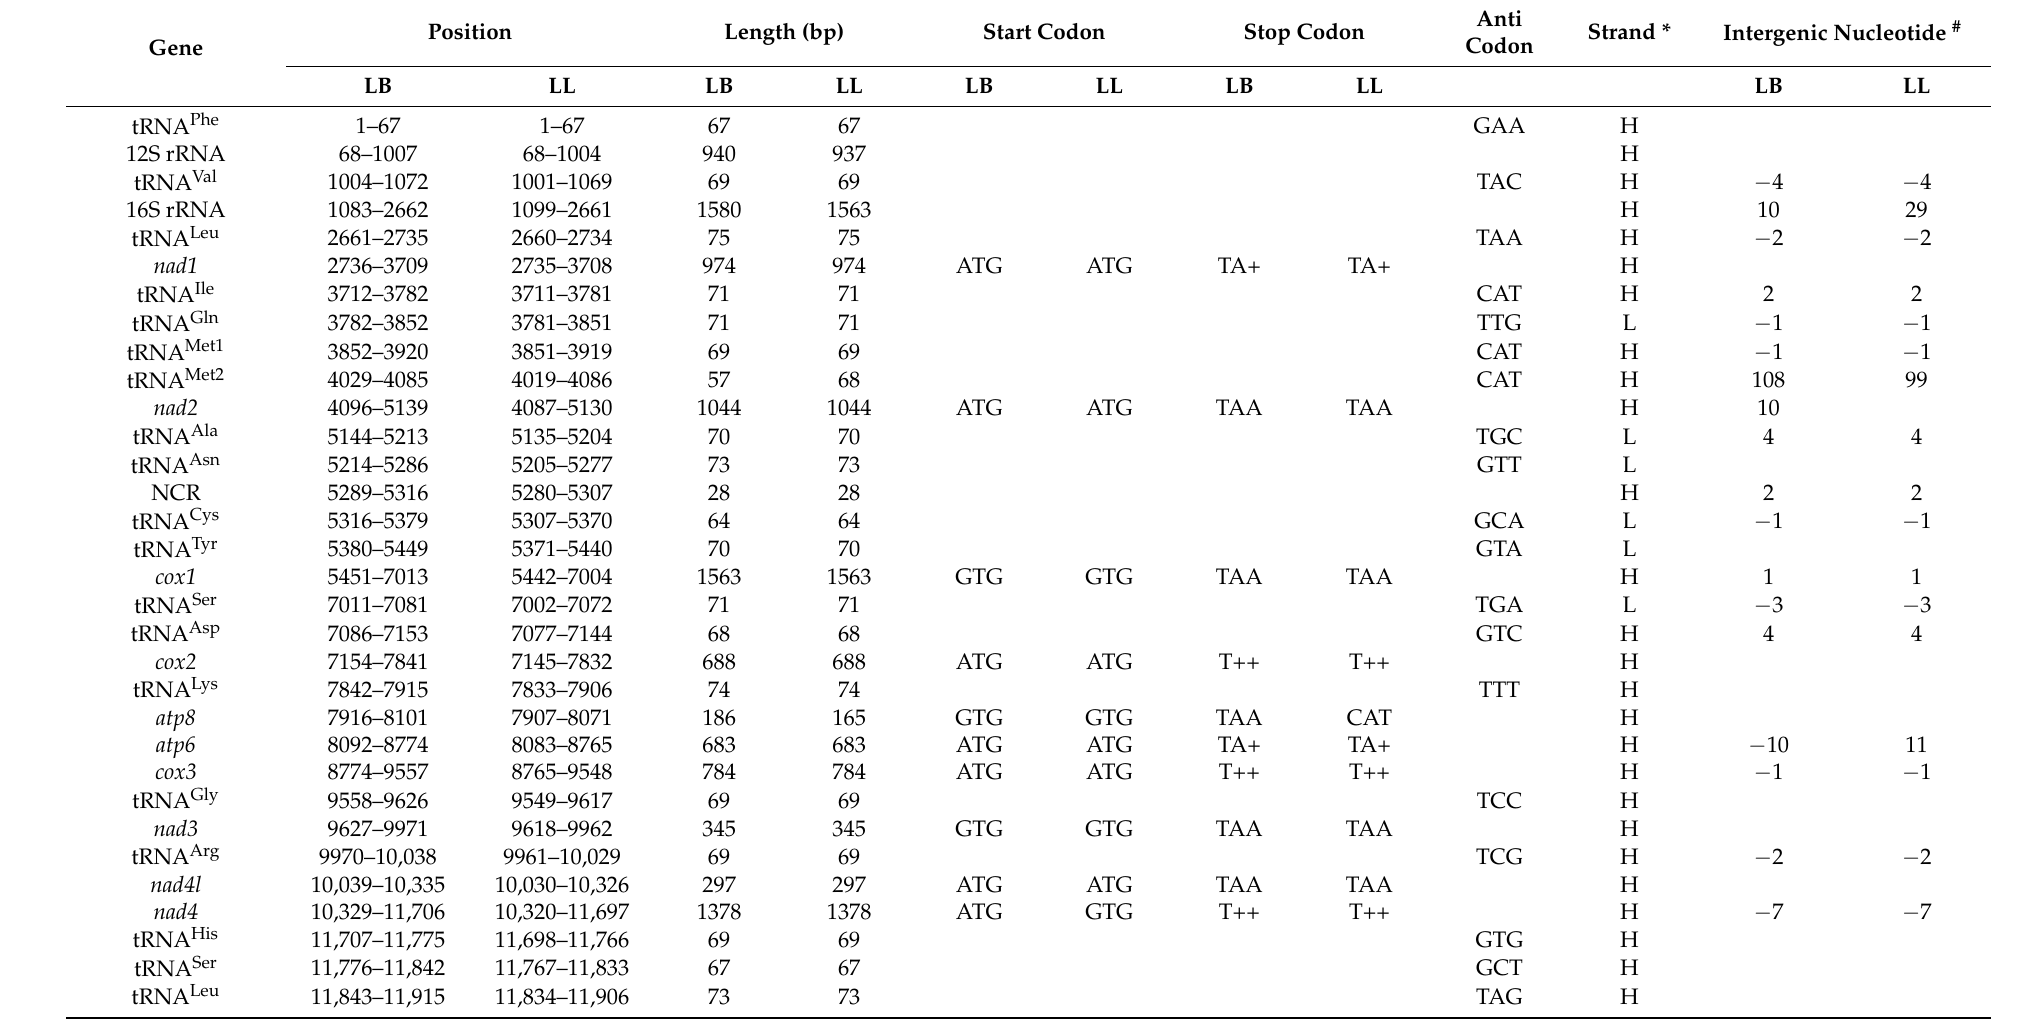
Table 1. Characteristics of the mitogenome of L. boringii (LB) and L. liui